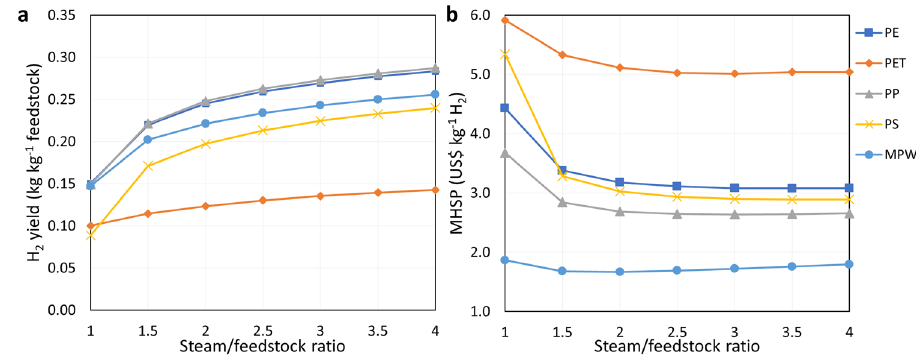
Fig. 2 Hydrogen yield and minimum hydrogen selling price of varied steam/feedstock ratio in Scenario 1 at 2000 oven-dry metric tons per day. a Hydrogen yield. b minimum hydrogen